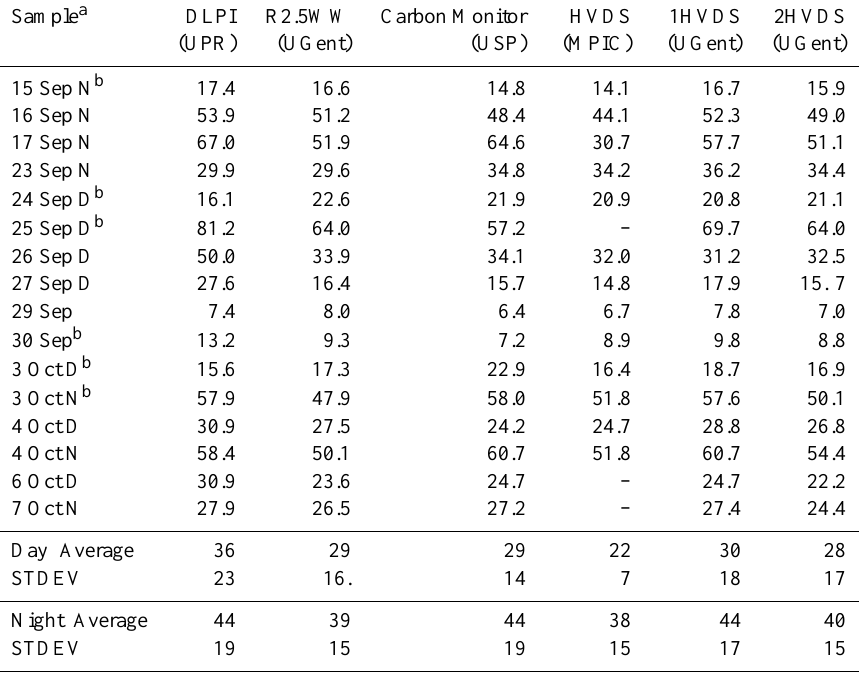
Table 2. TC concentration results from the DLPI and different filter systems. These samples were collected during the dry period of the LBA-SMOCC-2002 campaign. All concentrations are given in µgm − 3 . STDEV refers to the standard deviation of the